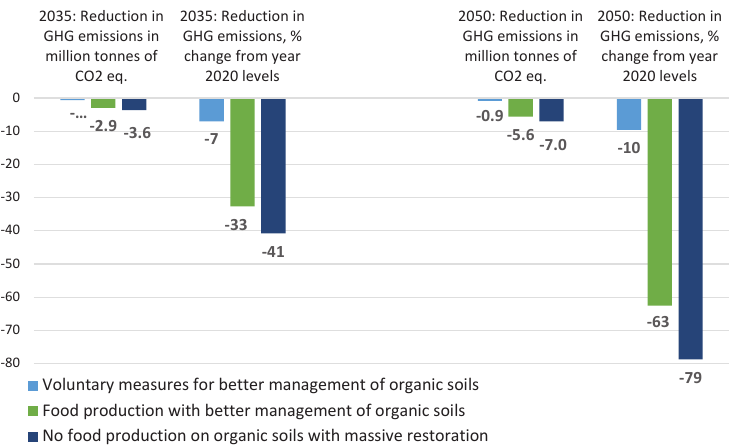
Fig. 3. The potential in reducing GHG emissions from organic soils in Finnish agriculture with three different scenarios (2035 and 2050)